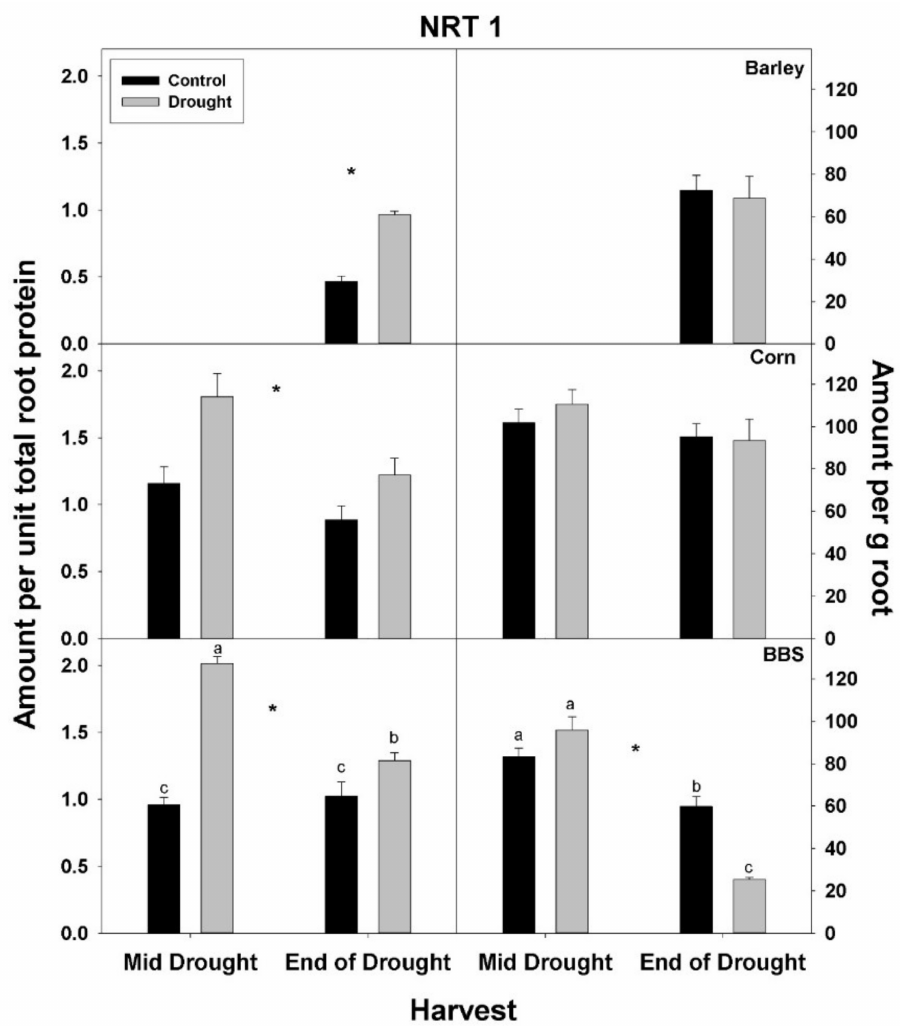
Figure 5. Effects of control vs. drought treatments on the concentration of the nitrate-uptake protein, NRT1, of roots in barley, corn, and big bluestem (BBS). Each bar represents mean + 1 SE (standard error). Within each panel, bars not sharing the same letters are significantly different. For each response variable, significant effects of drought (ANOVA), across both harvest in corn and big bluestem, are indicated with an asterisk